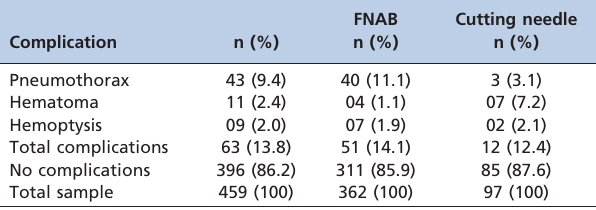
Table 4 - Distribution of complication rates for CT-guided biopsies of lung